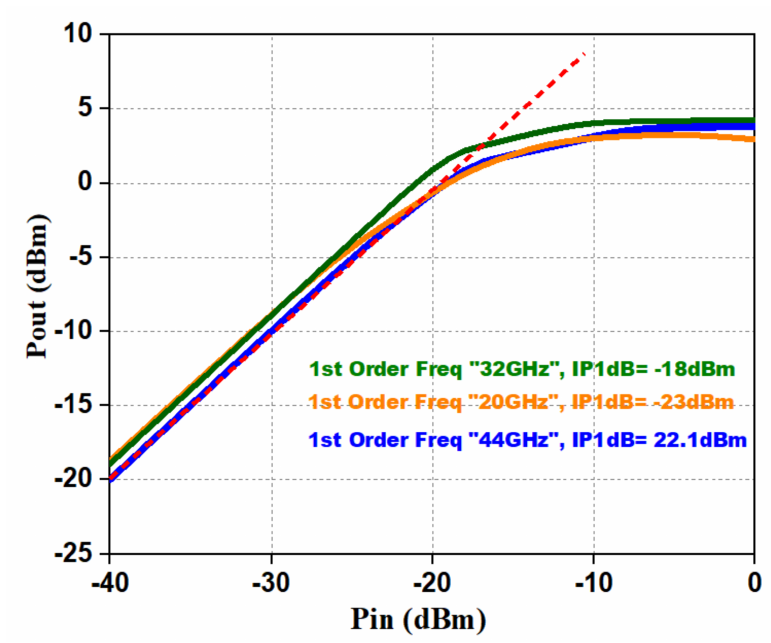
Figure 14. Pout vs. pin and 1 dB compression point of the LNA.